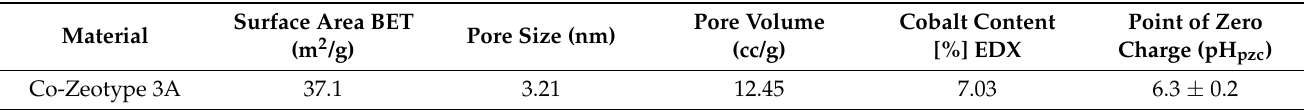
Table 2. Some physio-chemical properties of